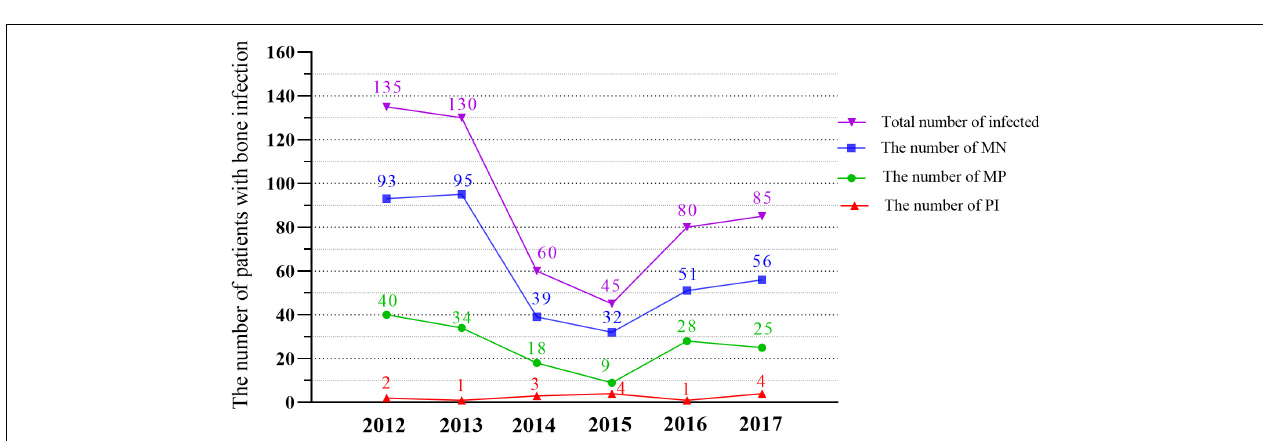
FIGURE 1 | The design of the overall flow chart of this study.